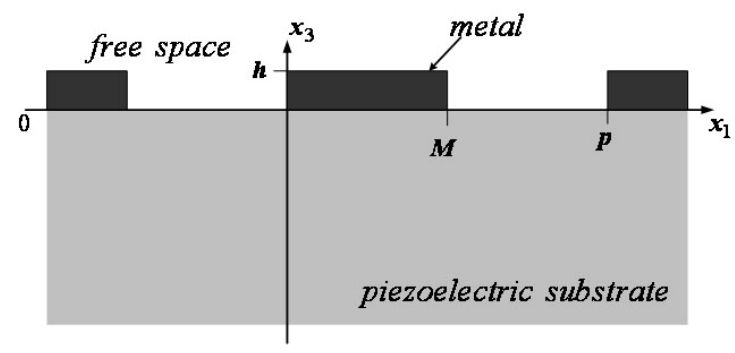
Figure 1. The coordinate